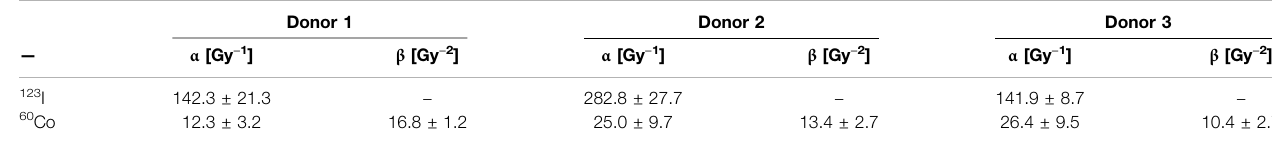
TABLE 2 | Slopes of the fi tted curves for 123 IUdR and 60 Co γ -ray exposures. The α - and β -values correspond to the linear-quadratic curve fi tting. Donor 1